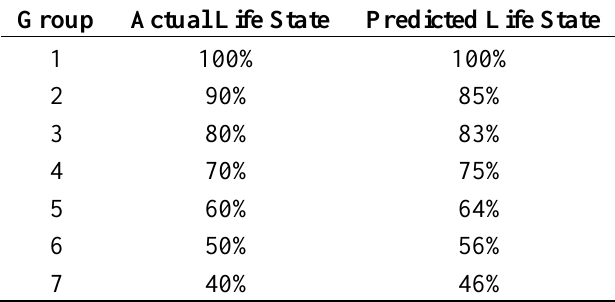
Table 1. Comparison between prediction and actual results for the degradation state of a